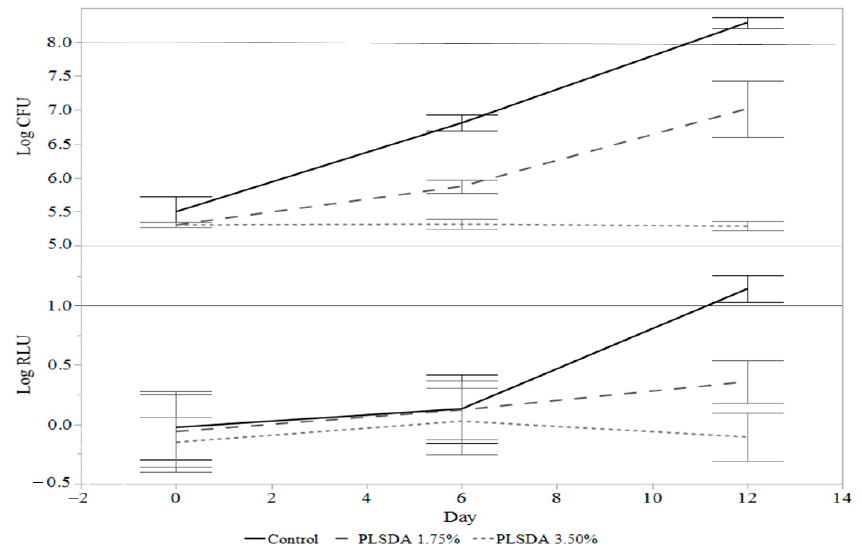
Figure 4. Comparison of L. monocytogenes Xen19 growth curves measuring colony forming units and relative light units in a miniature ham model with a 6 log colony forming unit (CFU) / g inoculation. Potassium lactate sodium diacetate (PLSDA) was used at 1.75% and 3.50% and compared to a ham with no antimicrobial treatment. The line at 1 log relative light unit (RLU) is proposed to distinguish samples with L. monocytogenes growth above 2 log CFU / g. The error bars are the standard deviation of the samples.